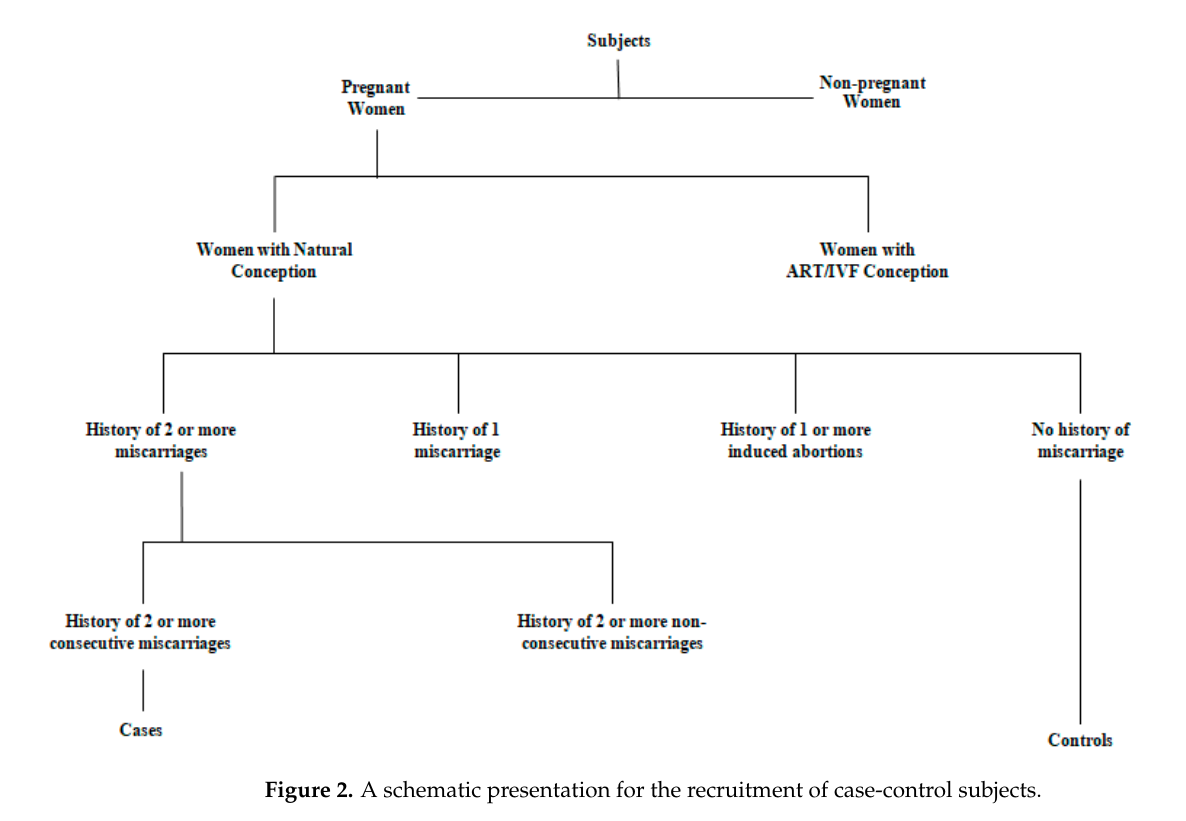
Figure 2. A schematic presentation for the recruitment of case-control subjects.